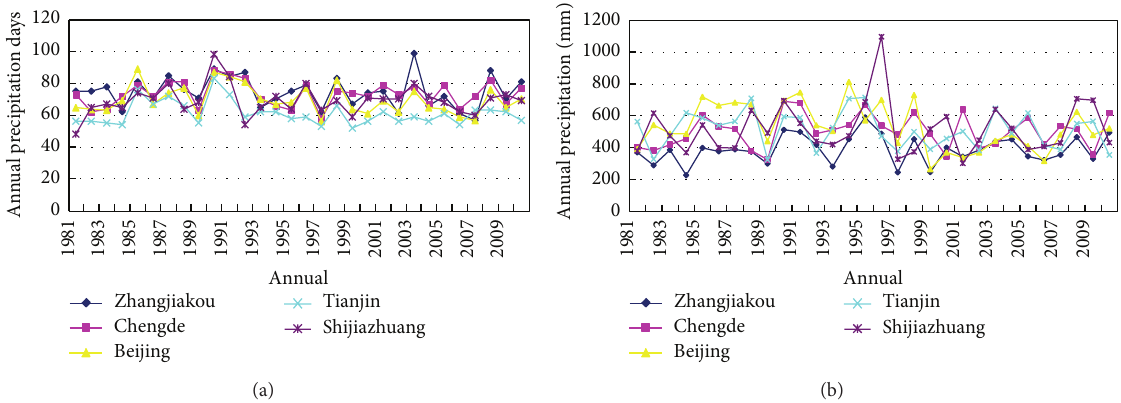
Figure 4: Interannual variations of precipitation in the five representative cities. (a) Annual precipitation days and (b) annual precipitation